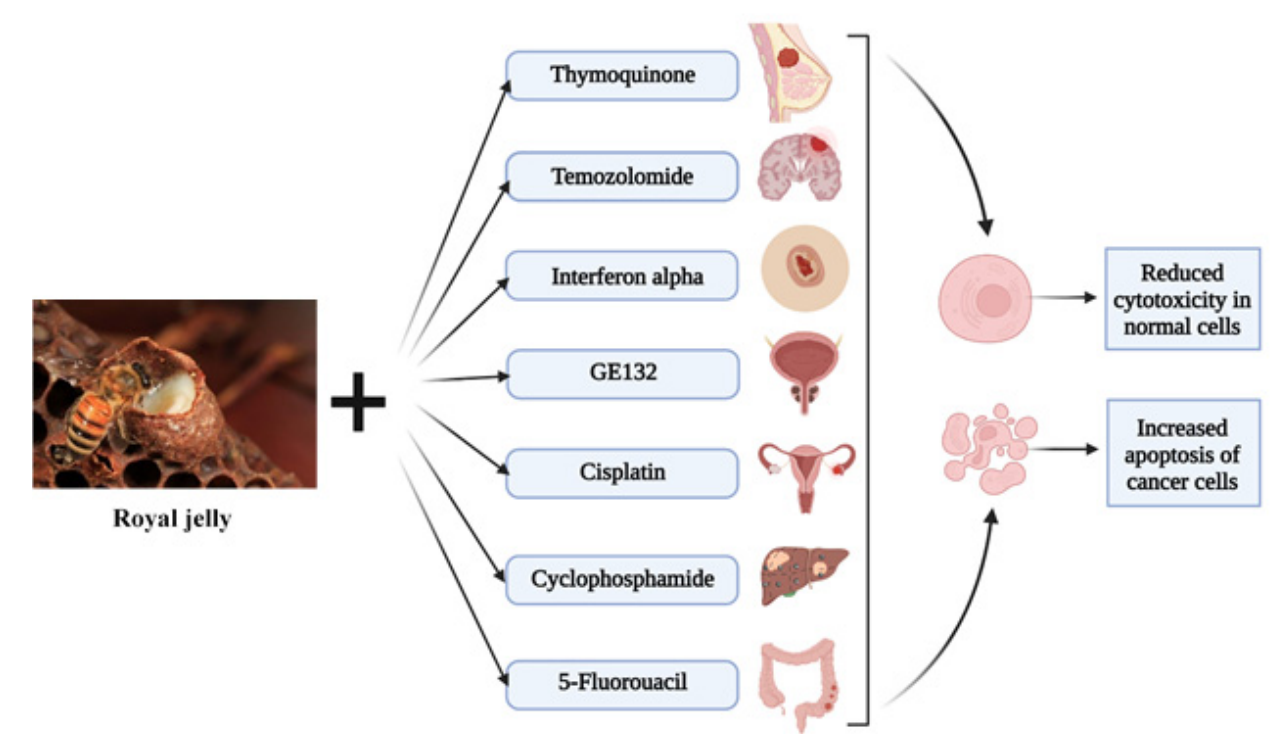
Figure 2. The effect of the synergistic interaction of royal jelly with anticancer drugs on cancer cells as well as normal cells. Table 1. Synergistic interaction between royal jelly and anticancer drugs.